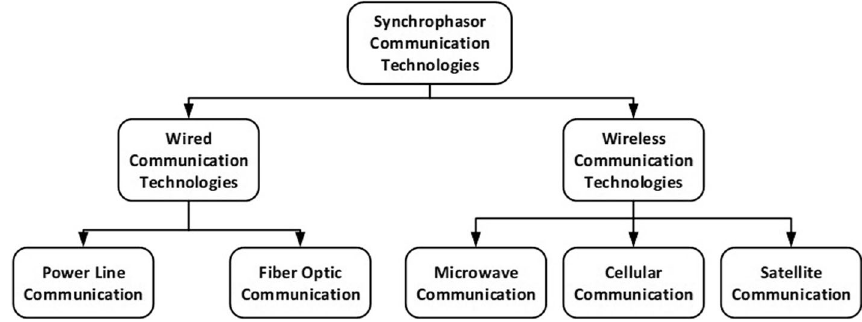
Fig. 6 The various synchrophasor communication technologies